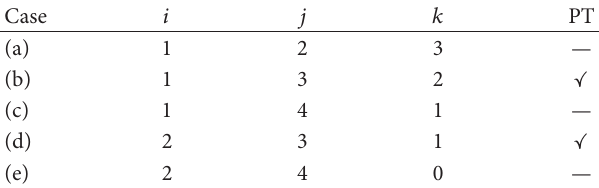
Table 1: Possible (𝑖, 𝑗, 𝑘) for 𝑚 = 6